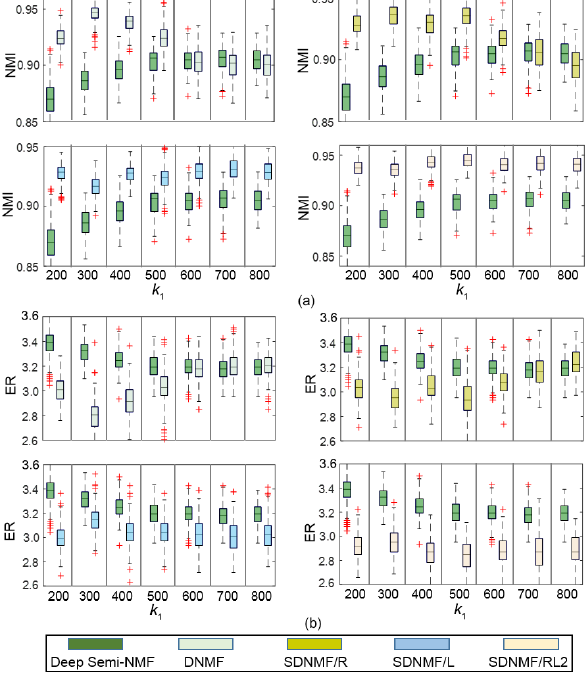
Fig. 1 Comparison of two-layer models with layer size = [ k 1 , 160] in terms of (a) NMI and (b) ER. Each sub-figure shows the results of deep semi-NMF and our models for comparison.